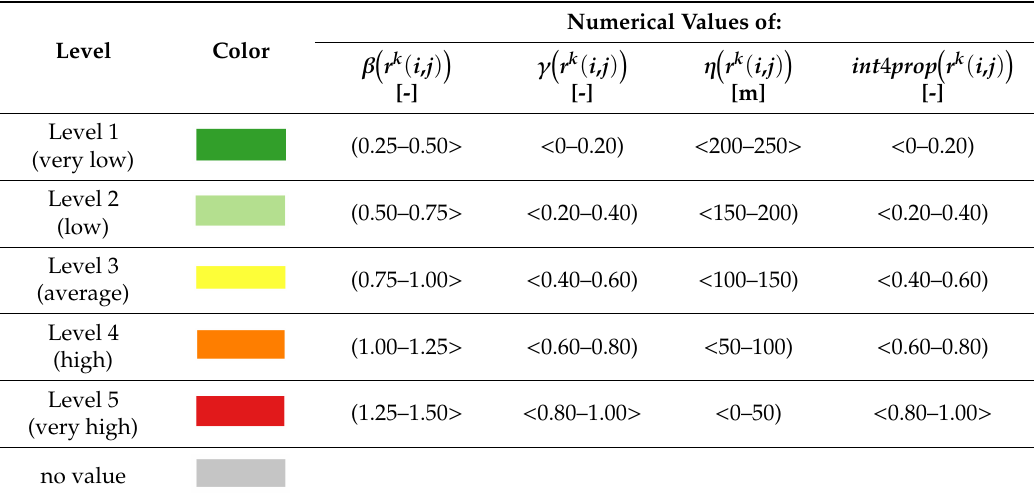
Table 2. Levels of connectivity for each